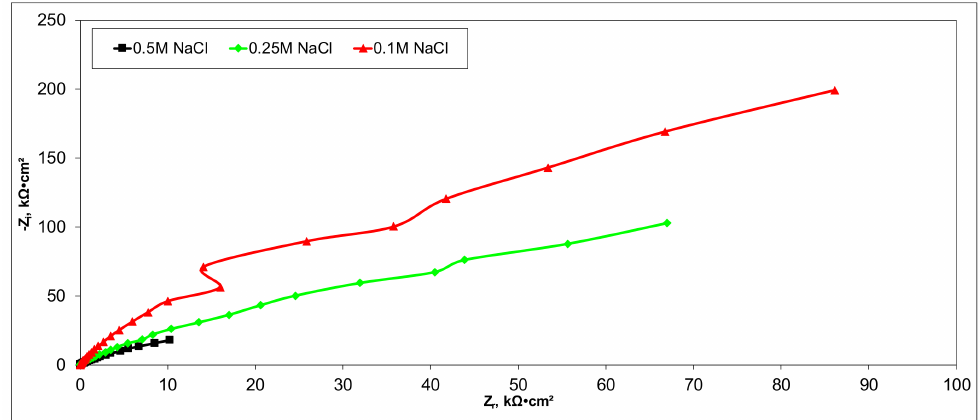
Figure 10. Nyquist plots for the X1 variant in NaCl: 0.5M, 0.25M, 0.1M.